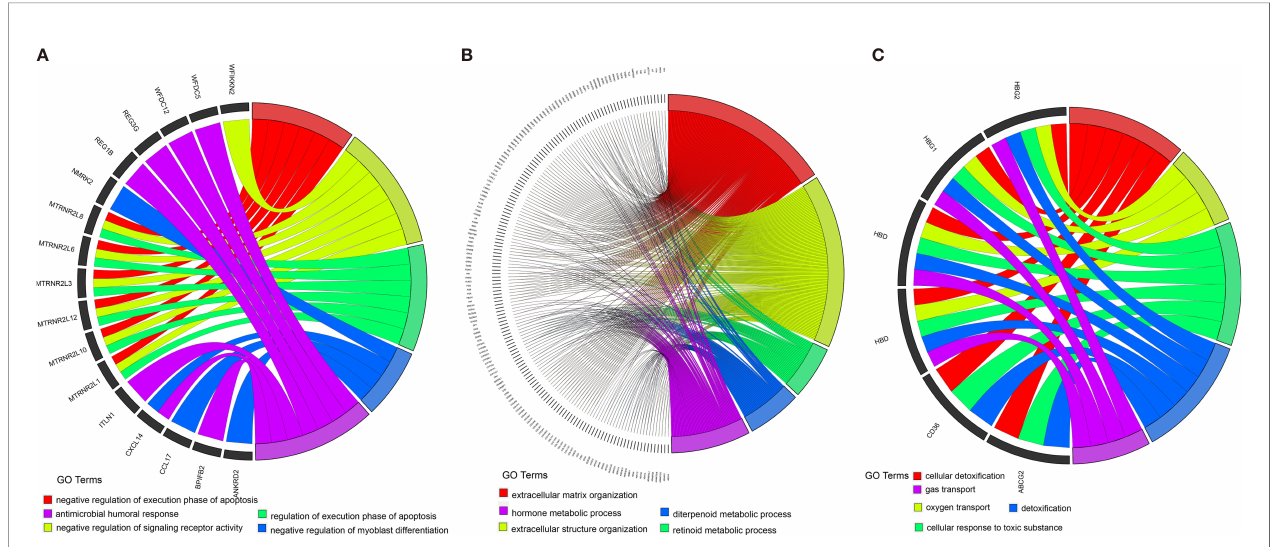
FIGURE 7 | Enrichment analysis of the differentially expressed genes in three different subclasses: C1 (A) , C2 (B) , and C3 (C)